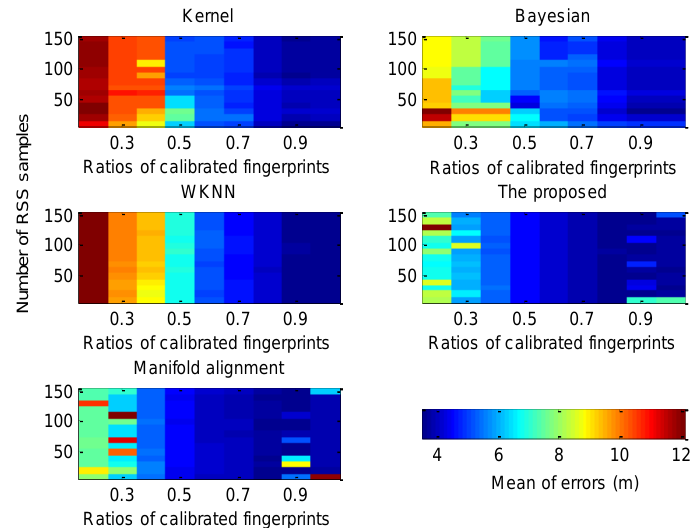
Figure 5. Mean of errors under different numbers of RSS (Received Signal Strength) samples at each RP and the ratios of calibrated